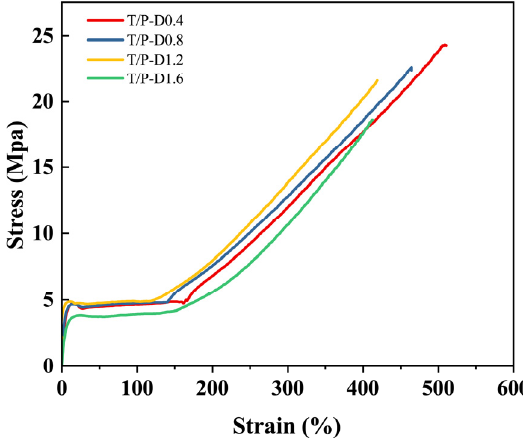
Figure 6. Stress–strain curves of T/E-Dx composites.